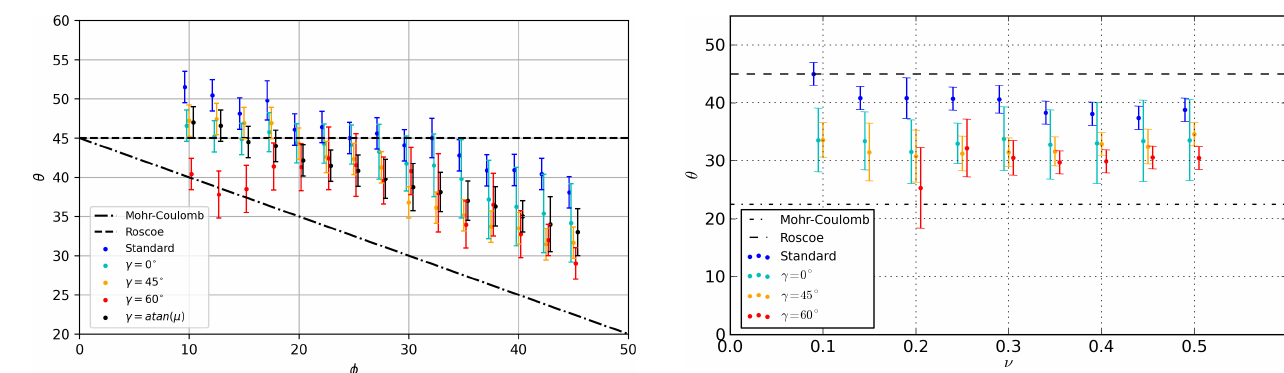
Figure 9. Sensitivity of the LKF orientation ( θ , degrees) on the an- gle of internal friction ( φ , degrees) in uniaxial loading experiments using different correction path angles ( γ ). The correction path angle γ = a tan (µ) implies that the stress correction path is perpendicular to the yield curve. The theoretical LKF orientation from the Mohr– Coulomb and Roscoe theories is indicated by dashed–dotted and dashed lines, respectively, for reference.